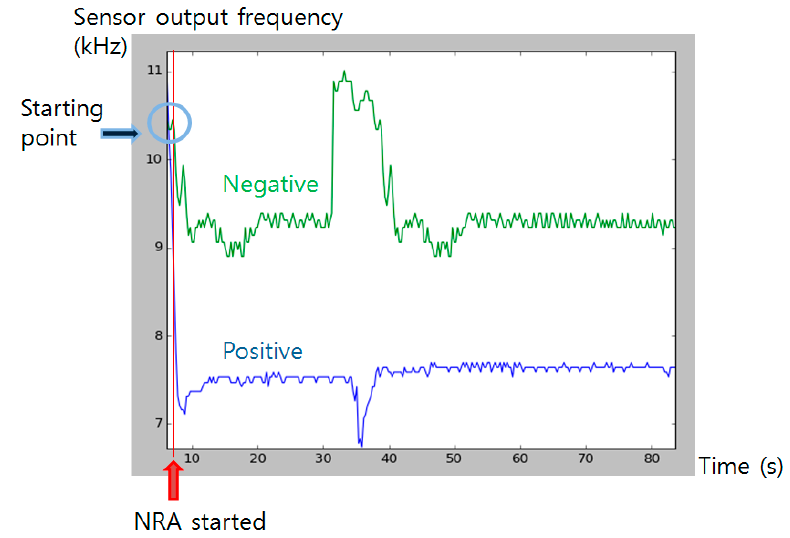
Figure 11. Color sensor output profiling after the injection. Blue graph shows positive signal (color pigment formed) and green line shows negative control. Red line indicates the time that NRA solution was injected. Blue circle indicates the initial sensor output value at the starting time.